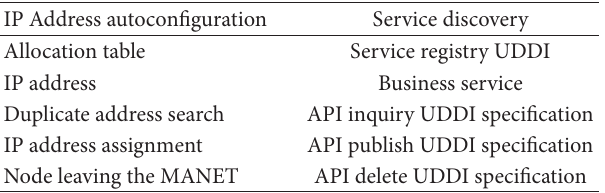
Table 1: BeeAdHocServiceDiscovery main components mapping from IP address autoconfiguration into service